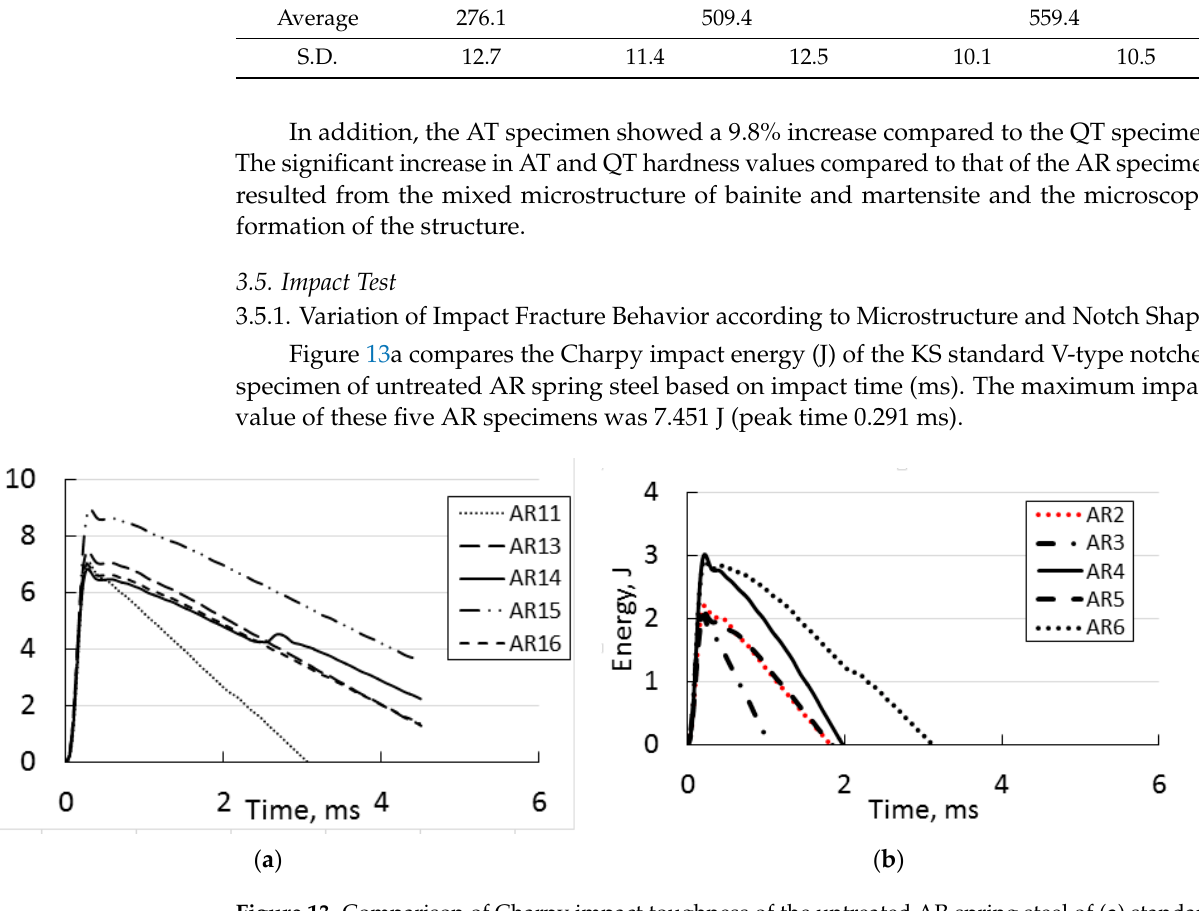
Figure 13. Comparison of Charpy impact toughness of the untreated AR spring steel of ( a ) standard V ‐ type notch, and ( b ) sharp I ‐ type notch.